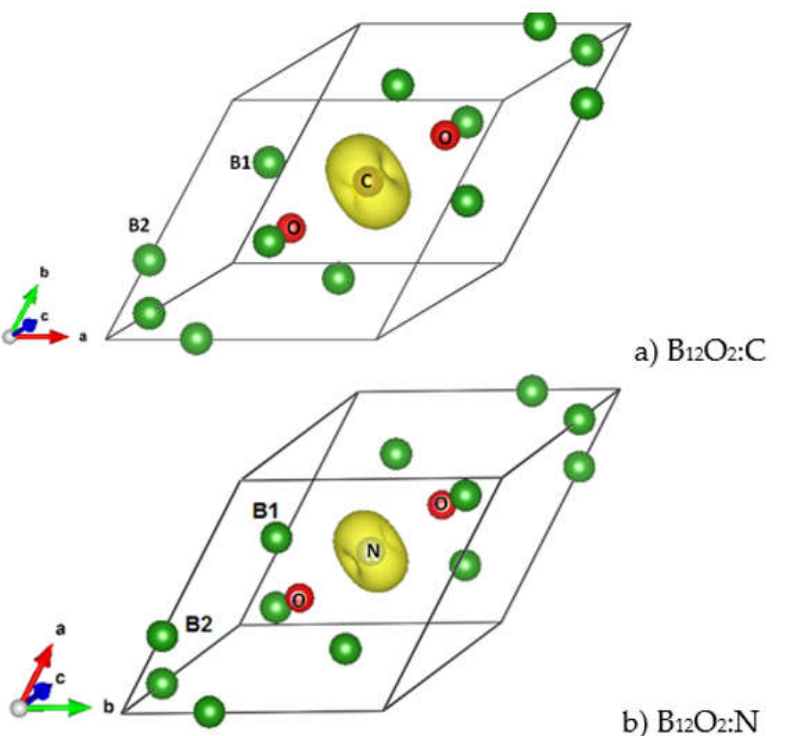
Figure 4. (color). Magnetic charge density in the two magnetically stable ternary compounds B 12 O 2 :C ( a ) and B 12 O 2 :N ( b ) exhibited by a torus centered on C and N and corresponding respectively to 1.9 µ B and 1 µ B magnetic